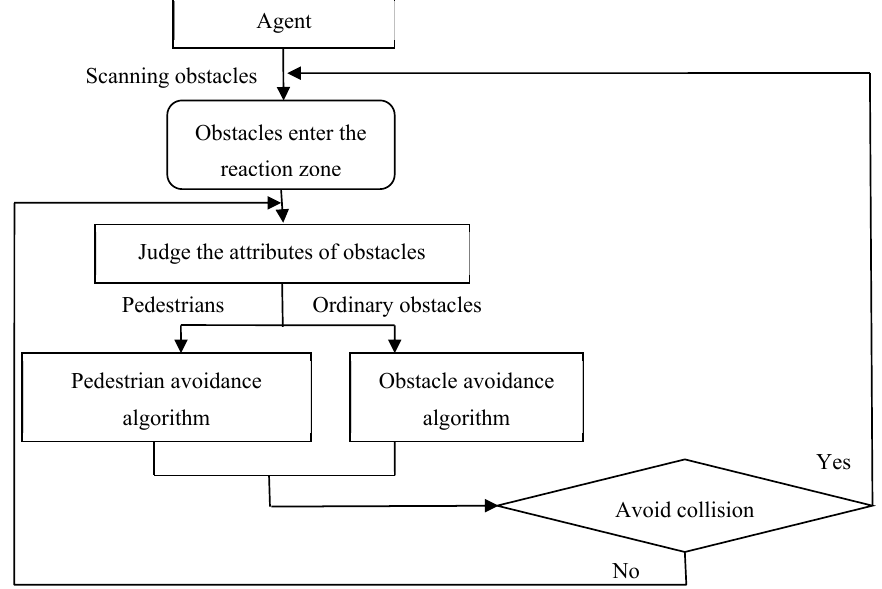
Figure 3. The flow chart of the agent walking.